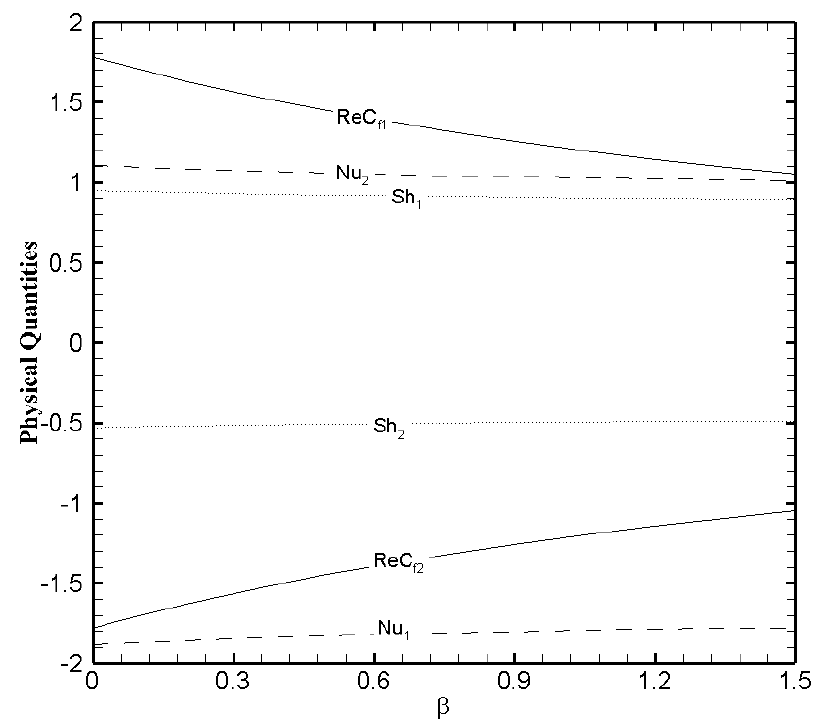
Figure 14. The physical quantities with β when ζ = P = κ = Ha = Br = δ θ 2 = F k = 1, N b = 0.2, N t = 0.1 and δ θ 1 = 0.5.